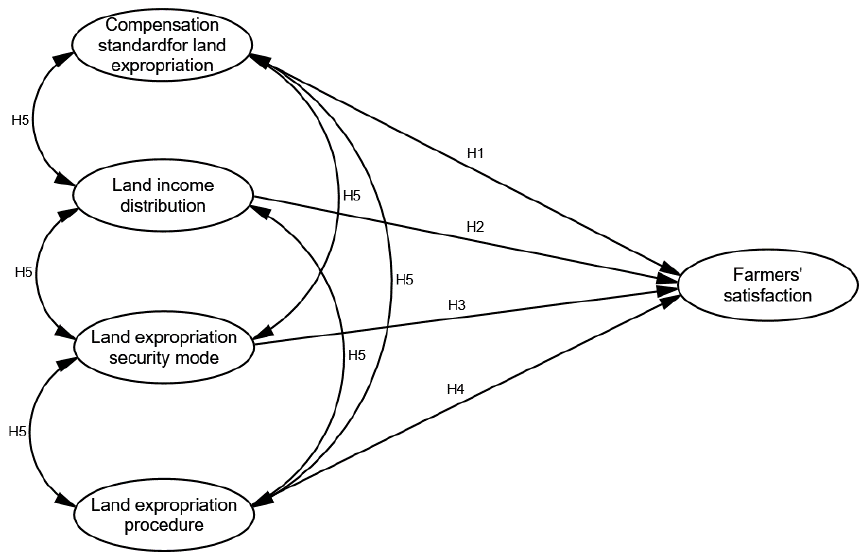
Figure 1. Research